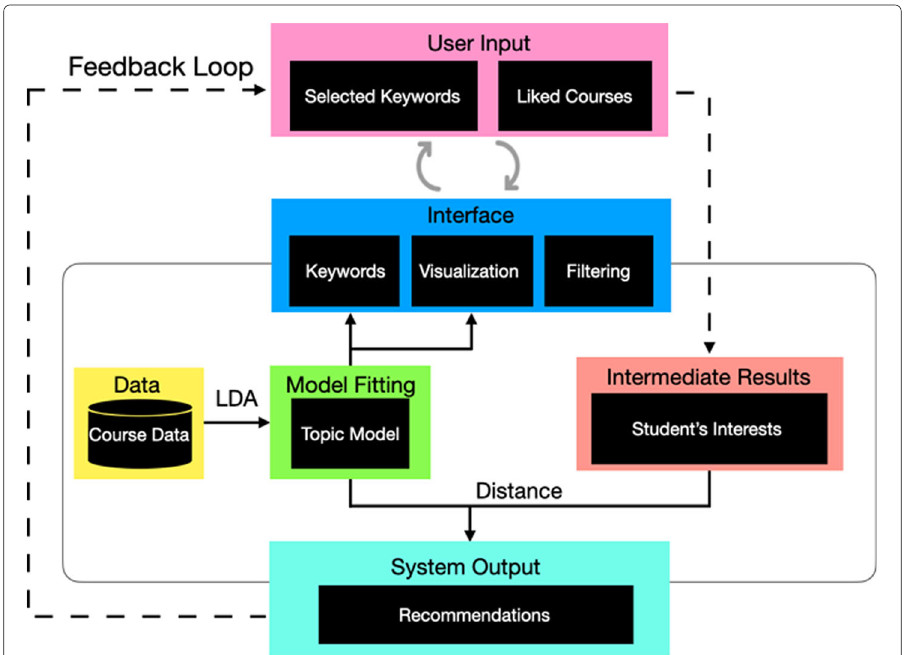
Fig. 5 Architecture of the course recommendation